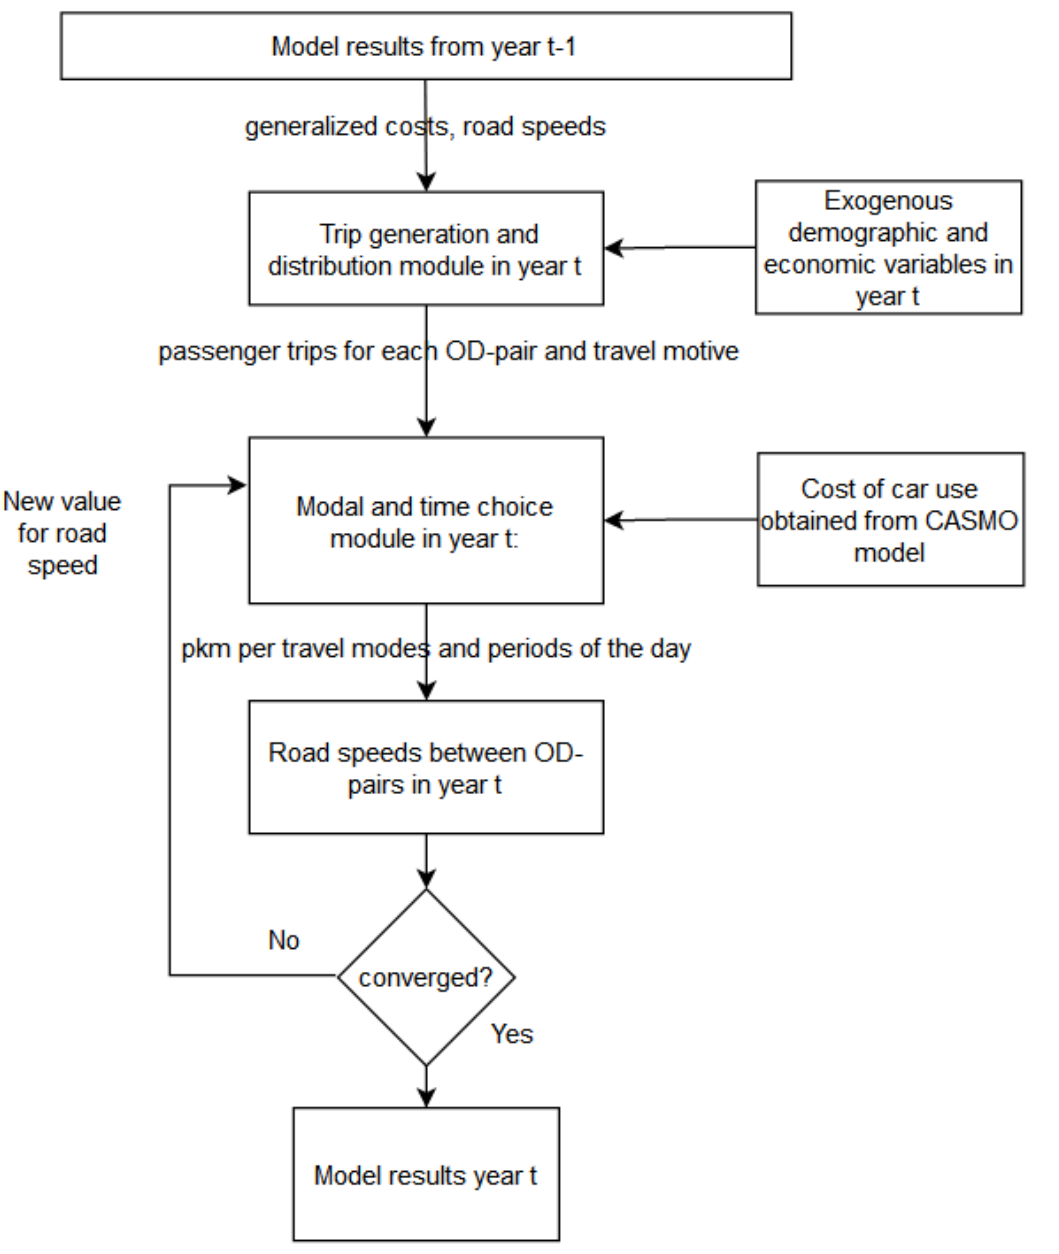
Figure 1. The general structure of the PLANET